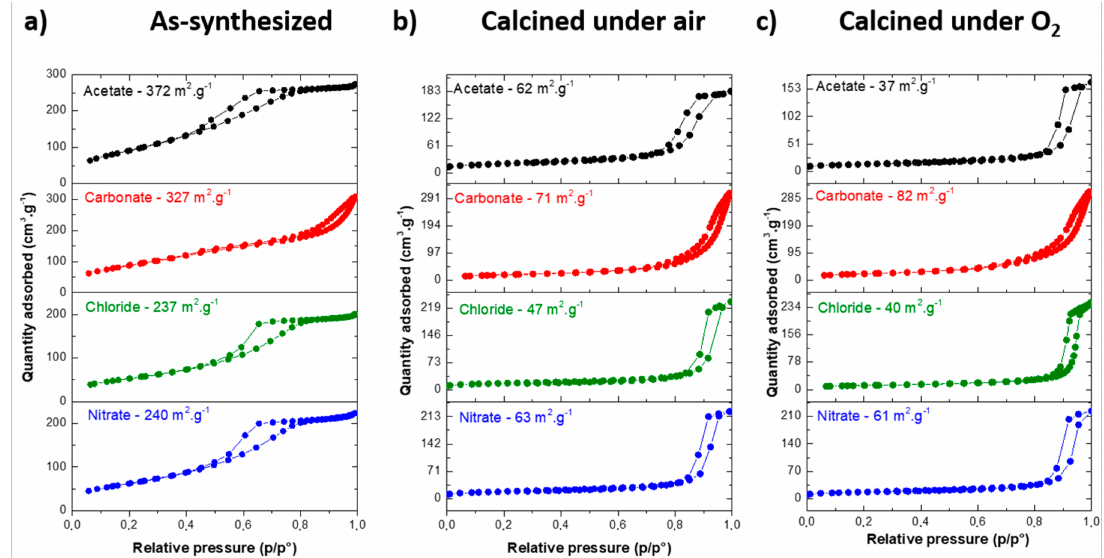
Figure 2. N 2 adsorption and desorption isotherms of ( a ) as-synthesized; ( b ) calcined under air (350 ◦ C, 2 h) and ( c ) calcined under O 2 (350 ◦ C, 2 h) MgF 2 prepared from acetate, carbonate, chloride and nitrate magnesium